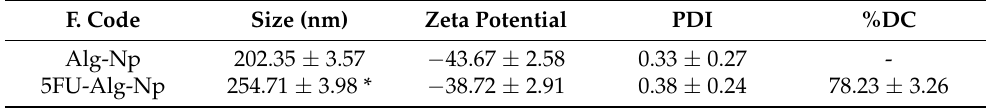
Table 1. Size, zeta potential, and %DC of nanoparticles. F.